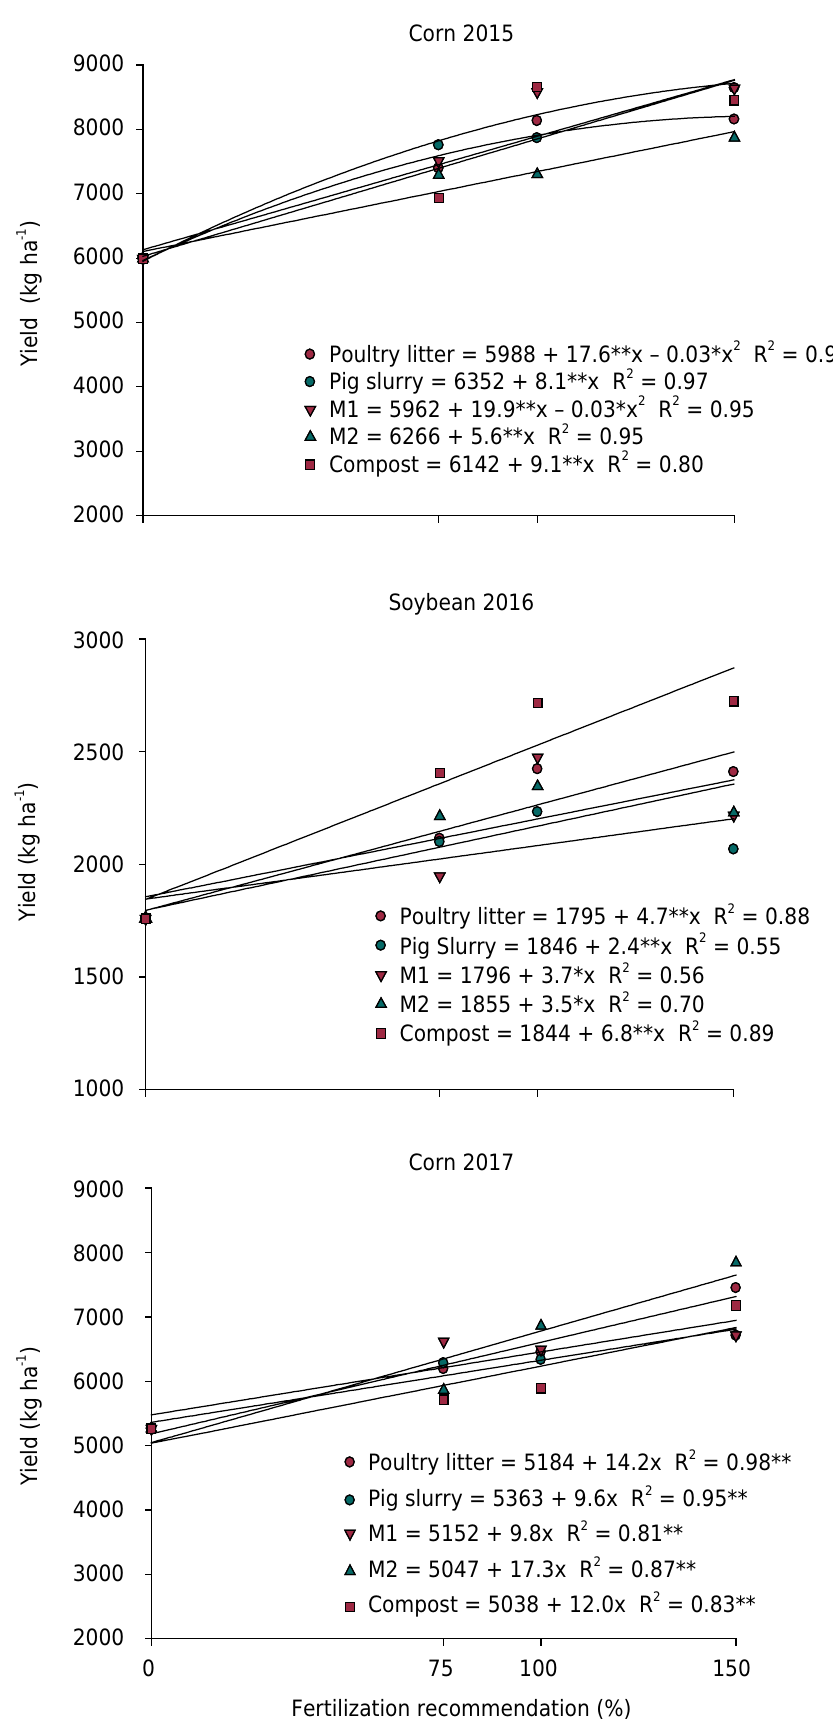
Figure 2. Soybean and corn yield (kg ha -1 ) in response to the use of increasing rates of organic and mineral fertilizers in a Rhodic